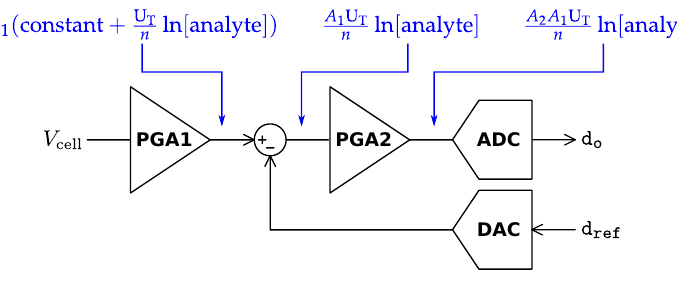
Figure 7. Generic potentiometric readout